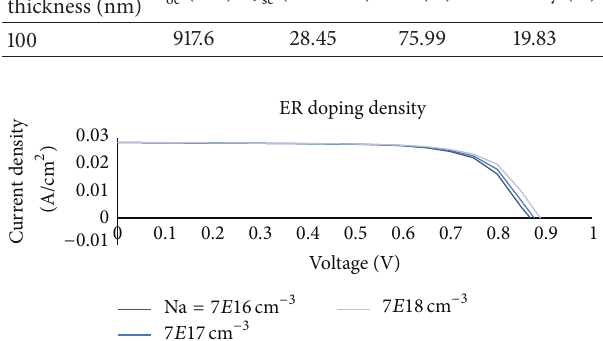
Figure 9: Photocurrent-voltage characteristics of CdTe cell at different doping densities of ER layer.